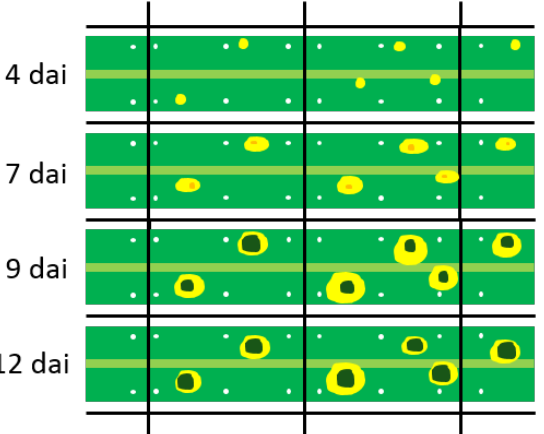
Figure 2. Scheme of the referenced hyperspectral time series of a single leaf observed at four exemplary days. Reference points (white spots), fixating strings (in black), and the developing disease symptoms are